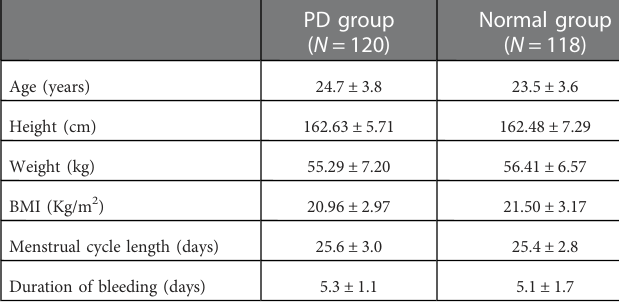
TABLE 1 Characteristics of the subjects ( N =238). TABLE 2 Results of sagittal spino-pelvic alignment parameters between PD and normal